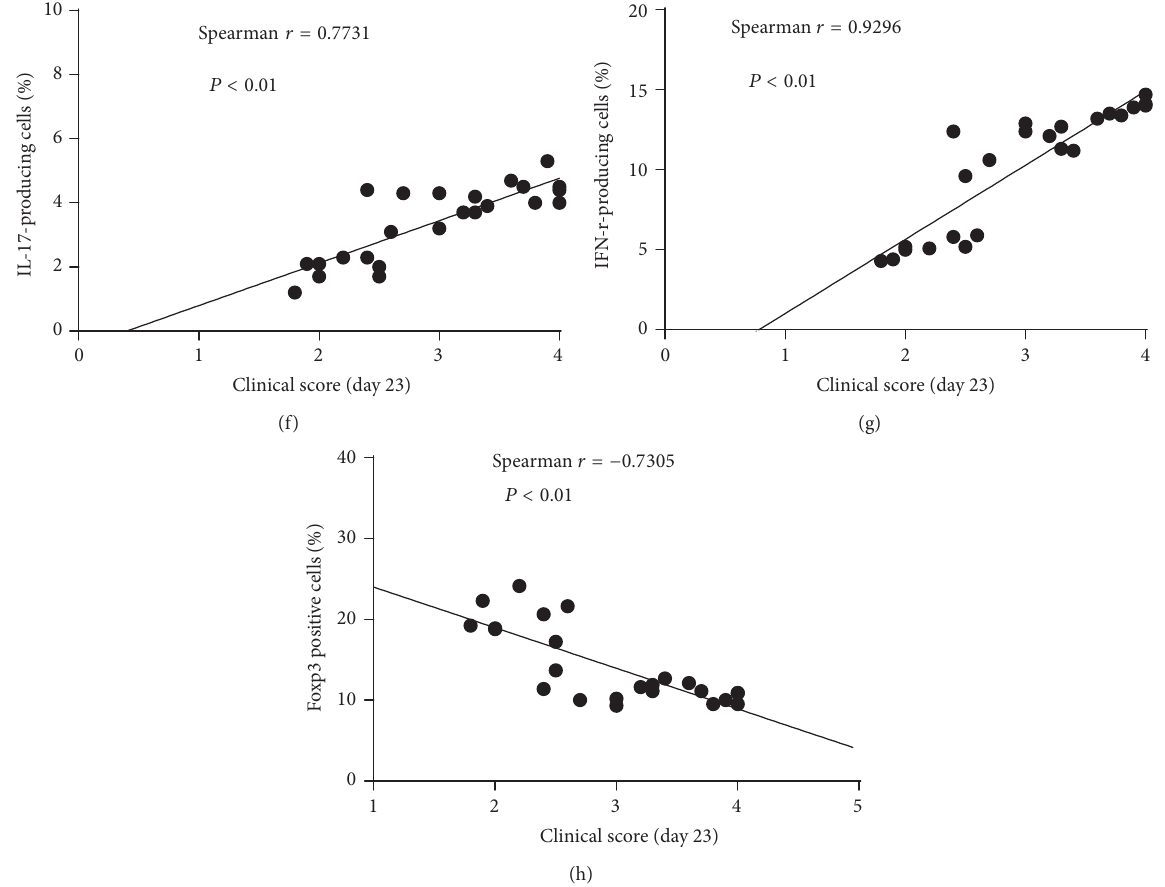
Figure 4: Adoptive transfer of Tofa-treated DCs decreased the proportion of IL-17+ and IFN- 𝛾 + T cells and induced expansion of CD25+Foxp3+ Tregs from EAE mice. CD4+ T cells were sorted from spleens of EAE mice on day 23 after immunization, IL-17, IFN- 𝛾 (a), and Foxp3 (b) were measured by intracellular cytokine staining, and a set of representative data of eight mice per group was presented. Histograms showed the percentage of IL-17A+ (c), IFN- 𝛾 + (d), and CD25+Foxp3+ cells (e). The values represent the means ± SEM, ∗ 𝑃 < 0.05 , and ∗∗ 𝑃 < 0.01 by ANOVA/Tukey’s post hoc test. The correlations between clinical scores (day 23) and the frequencies of IL-17-producing cells, IFN-r-producing cells and CD25+Foxp3+ cells in spleen of animal models (MOG pulsed mDCs with vehicle group, MOG unpulsed mDCs with 1 𝜇 M Tofa group, and MOG pulsed mDCs with 1 𝜇 M Tofa group) were presented as (f), (g), and (h), respectively, by using Spearmen’s rank